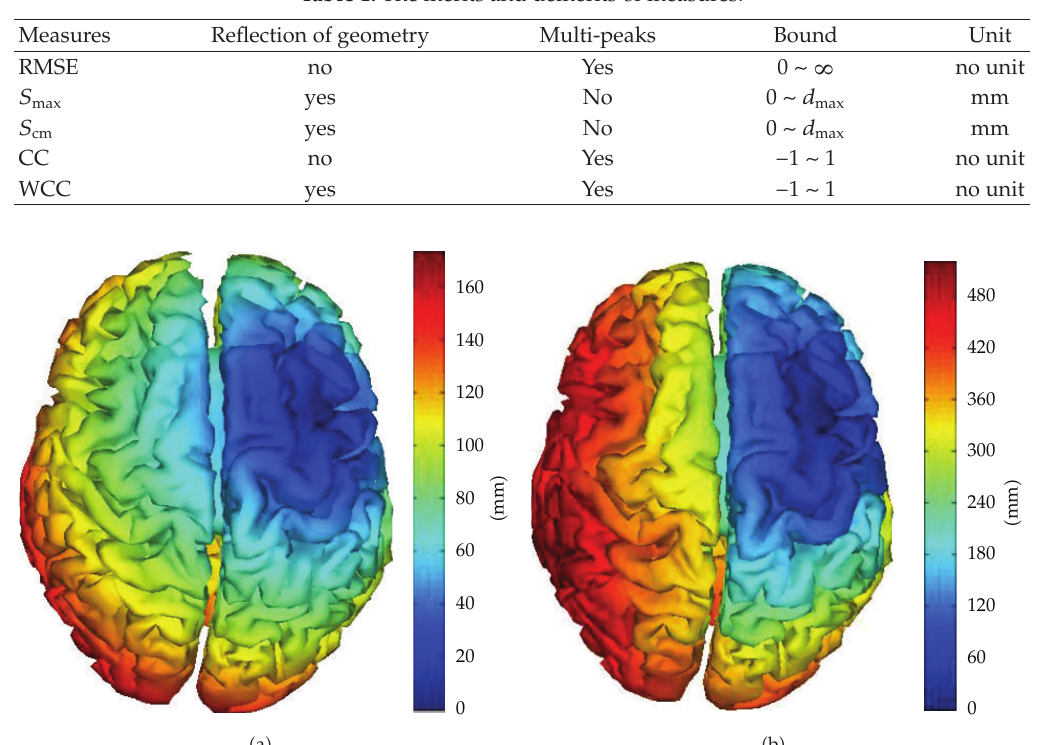
Figure 1: One column of (cid:2) a (cid:3) Euclidean and (cid:2) b (cid:3) geodesic distance matrix visualized on the cortical